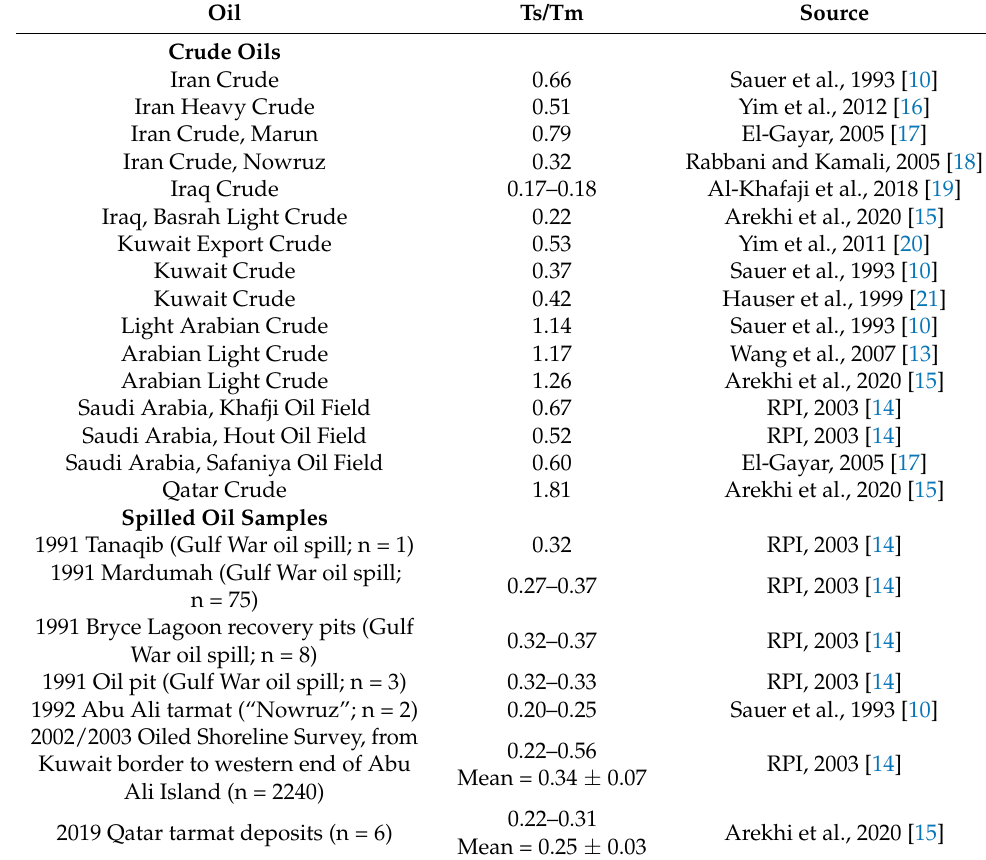
Table 1. Ts/Tm ratios for selected oils that are potential spill sources for the oil on Abu Ali Island and for spilled oil field samples collected during and after the Gulf War oil spills [10,13–21].